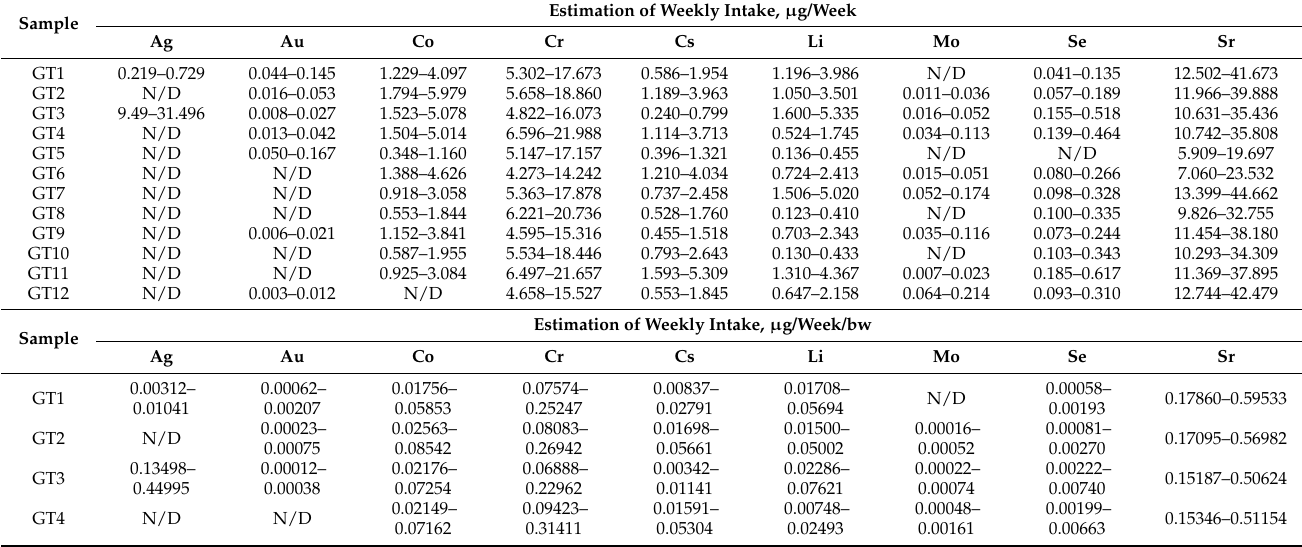
Table 5. The estimation of the weekly intake ( µ g/week) in the range of 600–2000 mL, and weekly intake per body weight estimation of the examined elements based on the consumption of green